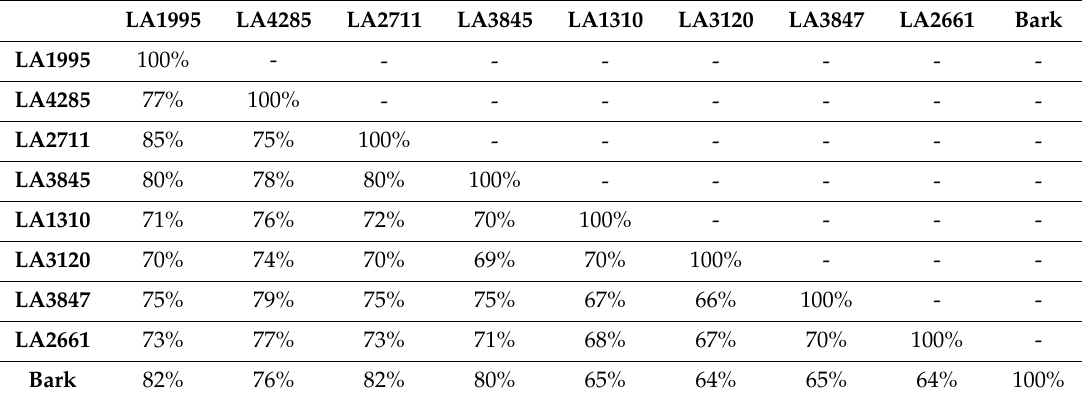
Bark Table 3. Similarity matrix based on the SCoT analysis of the eight wild accessions and hybrid of tomato.